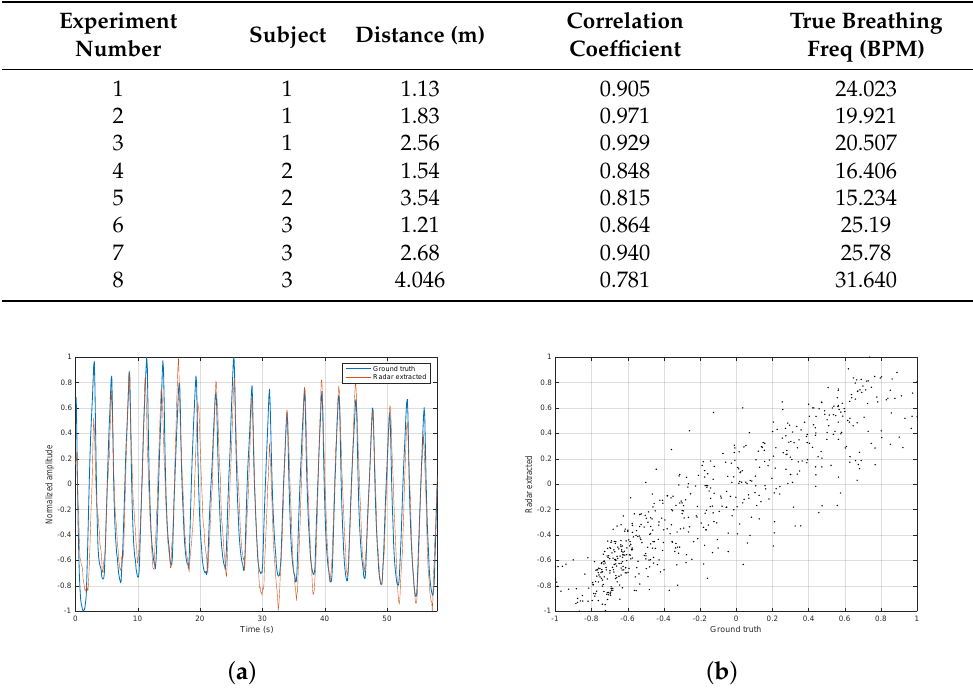
Table 3. Experiment scenarios correlation coefficients.